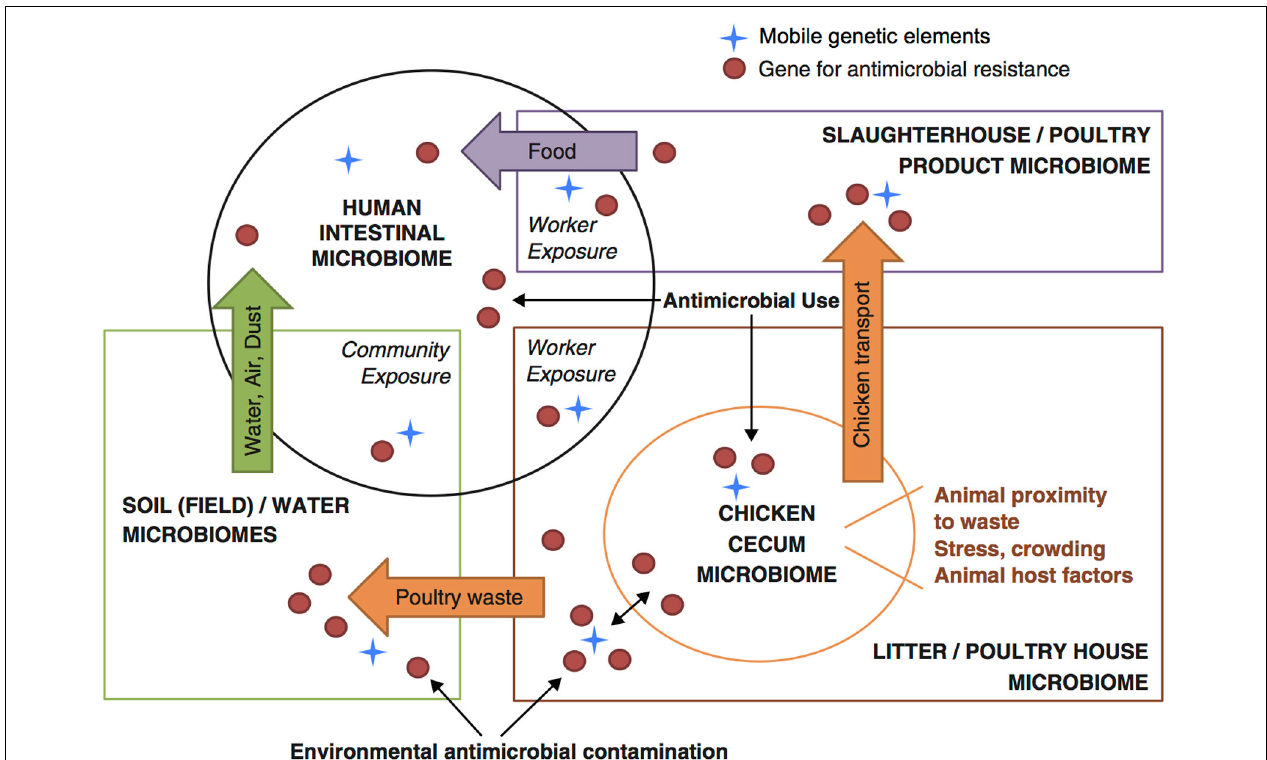
FIGURE 2 | Conceptual framework for understanding flow of resistance genes and mobile genetic elements across microbiomes within food animals, the environment, and human populations (based on Davis et al.,